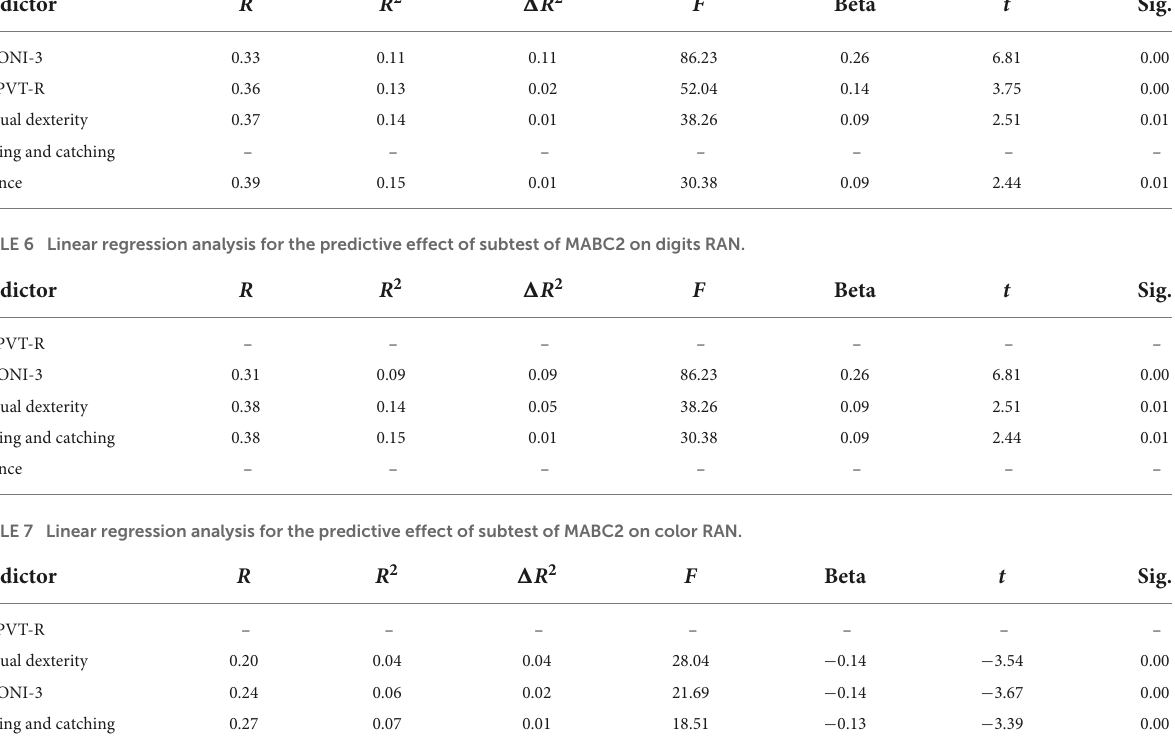
TABLE 5 Linear regression analysis for the predictive effect of subtest of MABC-2 on the onset of PA. Predictor